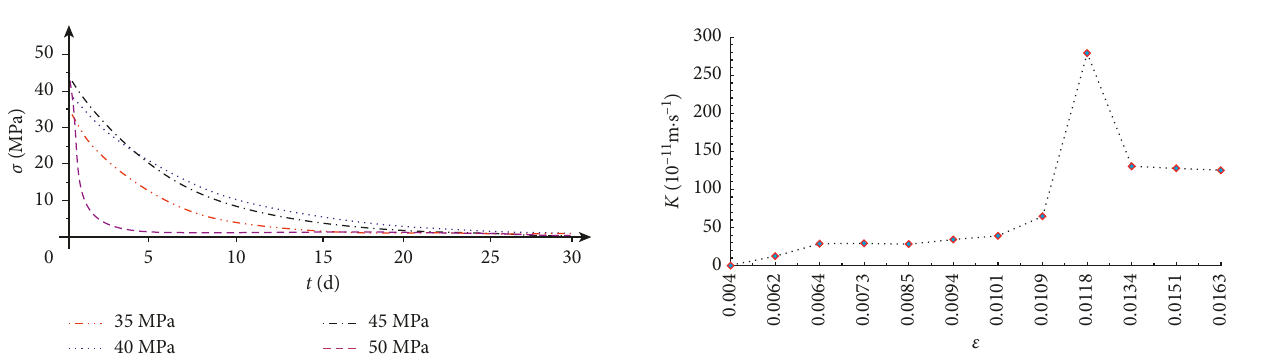
Figure 6: Relaxation characteristics of the specimens under dif- ferent loads.